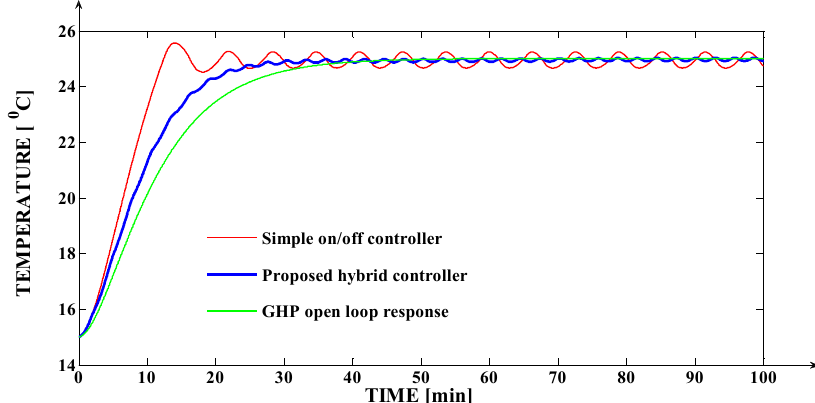
Figure 32. The simulation results obtained for the dynamics of the temperature inside the greenhouse.